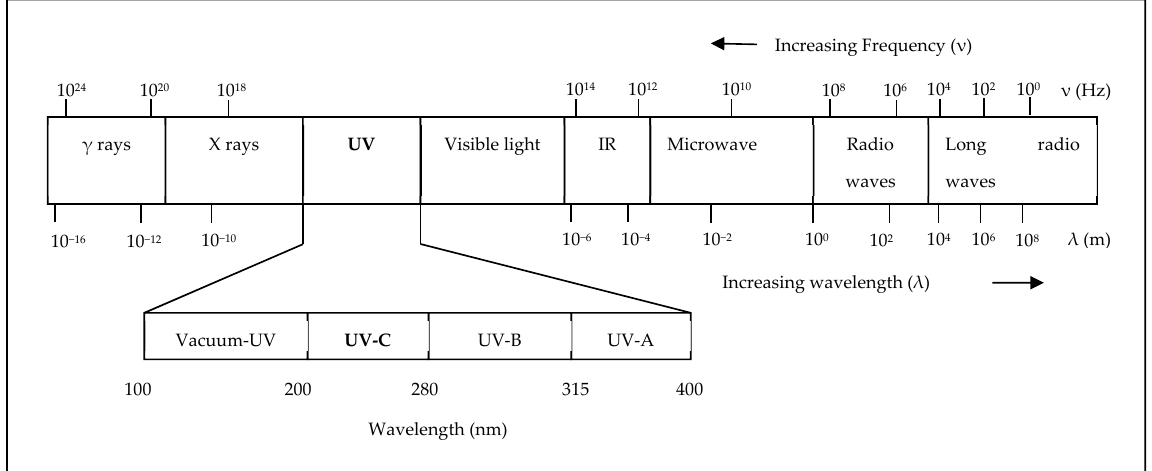
Figure 1. UV radiation and wavelengths [19–21].